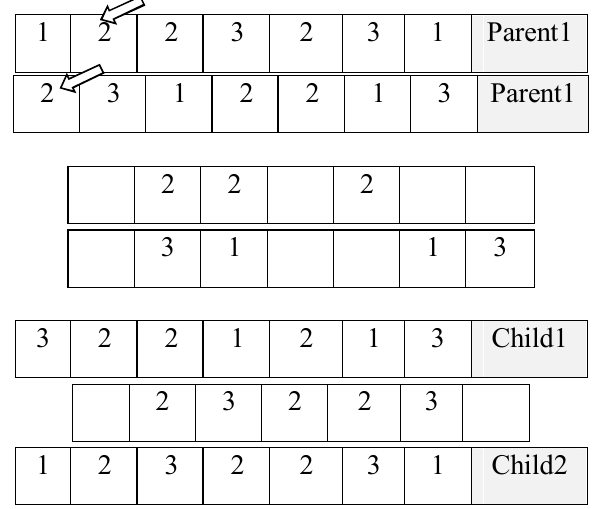
Fig. 3(a). Example of crossover on the sequence part